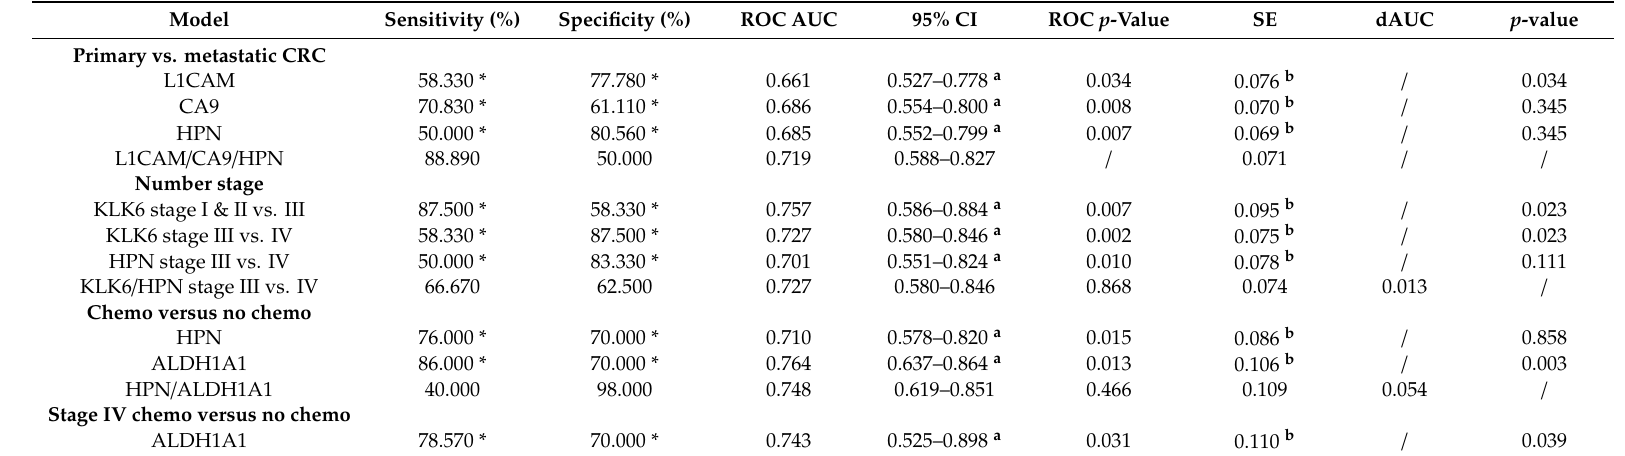
Table 4. Receiver operating characteristic (ROC) curves results and logistic regression